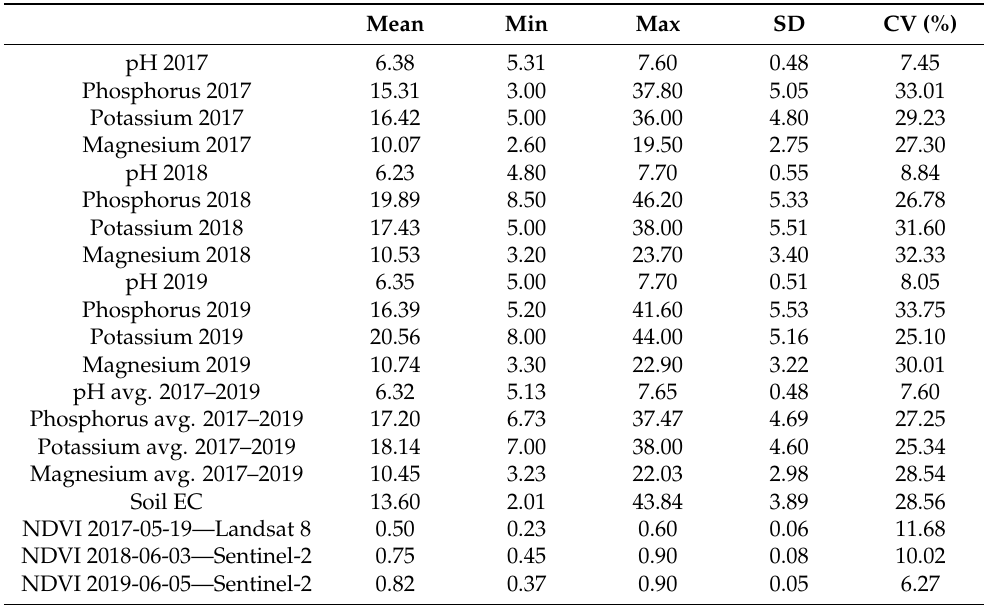
Table 3. Means, standard deviations (SD), ranges (min-max), and coefficients of variation (CV) for the studied